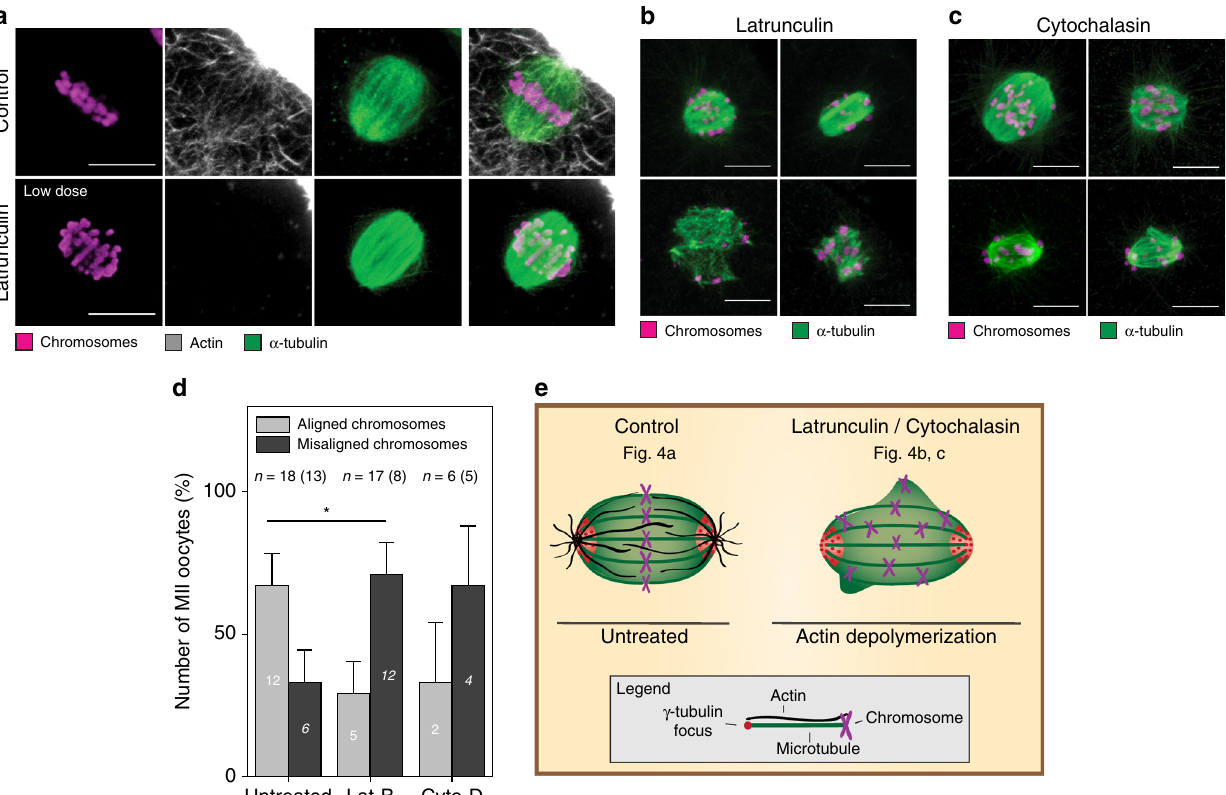
Fig. 4 Disruption of fi lamentous actin affects chromosome alignment and perturbs bipolar spindle architecture. a Representative z -projections of untreated human MII oocytes (upper panel, same oocyte as shown in Fig. 1a) and oocytes treated with 2.5 µ M latrunculin-B (lower panel) showing chromosomes (Hoechst), actin (phalloidin), and microtubules ( α -tubulin); z = 16 and 11 sections. Representative of n = 15 and 3 oocytes. b Examples of MII oocytes treated with 1 µ M (upper panel) or 5 μ M (lower panel) latrunculin-B showing chromosomes (Hoechst), actin (phalloidin), and microtubules ( α -tubulin); z = 4 sections. Representative of n = 4 (upper panel) and n = 8 (lower panel) oocytes. c Examples of MII oocytes treated with 5 µ g/ml (upper panel) or 10 µ g/ml (lower panel) cytochalasin-D showing chromosomes (Hoechst), actin (phalloidin), and microtubules ( α -tubulin); z = 4 sections. Representative of n = 4 (upper panel) and n = 2 (lower panel) oocytes. d Comparison of oocytes with aligned vs unaligned chromosomes in the absence or presence of actin depolymerizing agents (1, 2.5, 5 µ M latrunculin-B incubations for 5 to 60 min prior to fi xation; 5 µ g/ml and 10 µ g/ml cytochalasin-D for 25 and 60 min prior to fi xation). e Schematic illustration of chromosomes, microtubules, and actin at the spindle of MII oocytes upon treatment with actin depolymerizing agents. Scale bars, 10 μ m. n = total number of oocytes. The number of donors is speci fi ed within parentheses. Error bars represent standard error of the mean. Signi fi cance was tested using Fisher ’ s exact test. Asterisk denotes p -value: * < 0.05. Source data are provided as a Source Data fi